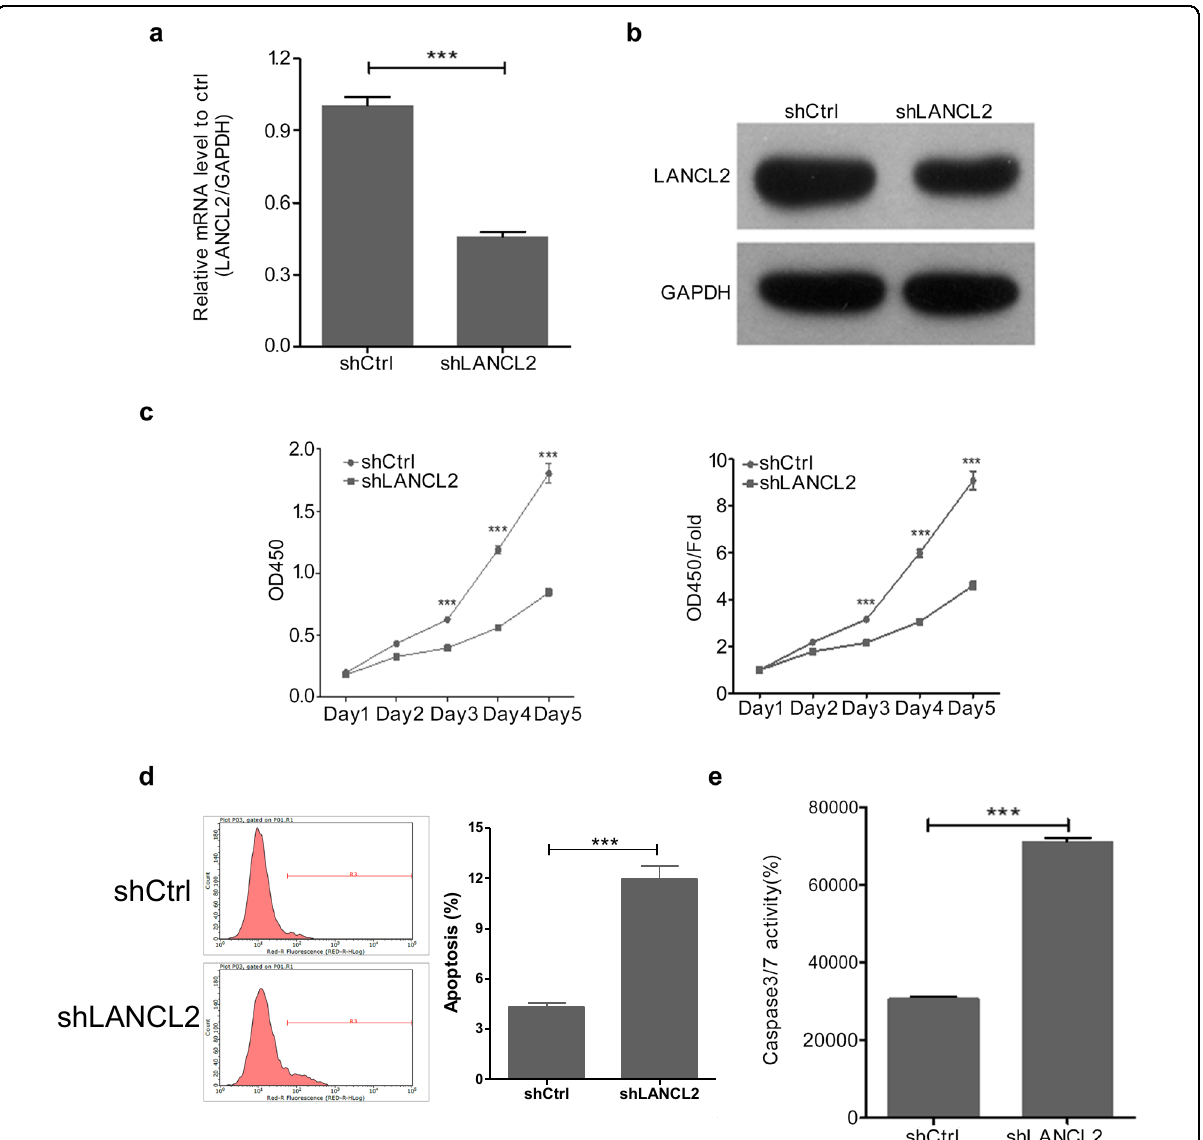
Fig. 3 LANCL2 knockdown inhibits HCC827 cell proliferation. a mRNA and b protein expression levels of LANCL2 in shLANCL2- or shCtrl-infected HCC827 cells. c CCK-8 cell proliferation assay (raw OD450 data (left) and relative fold-change in OD450 (right)) and d fl ow cytometry analyses of apoptosis using Annexin V staining in shLANCL2- and shCtrl-infected HCC827 cells. e Caspase-3/7 activity in shLANCL2- and shCtrl-infected HCC827 cells. * p < 0.05; ** p < 0.01; and *** p < 0.001 vs. shCtrl. Data presented as means ± SDs. All in vitro experiments: three biological replicates × three technical